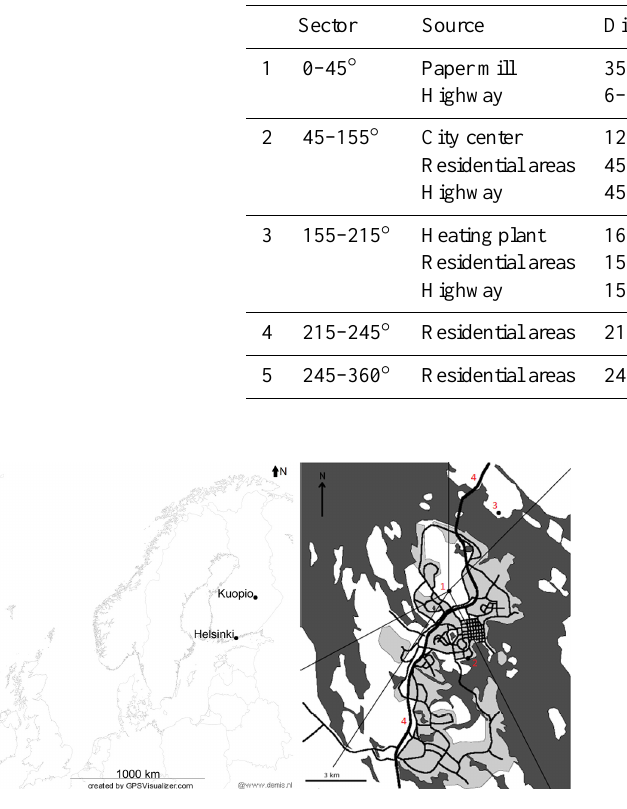
Figure 1. The location of Kuopio (left) and the map of the Kuopio area (right). Marked in the Kuopio area map are Puijo (1), a heating plant (2), a paper mill (3) and a highway (4). Dark-grey color indi- cates lakes; light-grey indicates residential areas and white forests. Also shown are the five sectors used in the data analysis to distin- guish the effect of local sources (described in Sect.